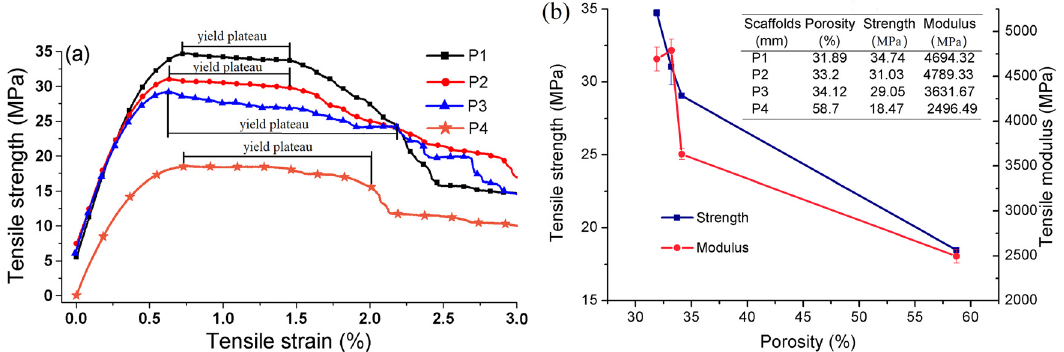
Figure 7: The relationship between: ( a ) strength and strain and ( b ) porosity and strength, modulus ( P1, P2, P3, and P4 represent the scaffolds with pores gradual between 0.4 and 0.8 mm, 0.6 and 1.0 mm, 0.8 and 1.2 mm, and 1.2 and 2.0 mm, respectively )